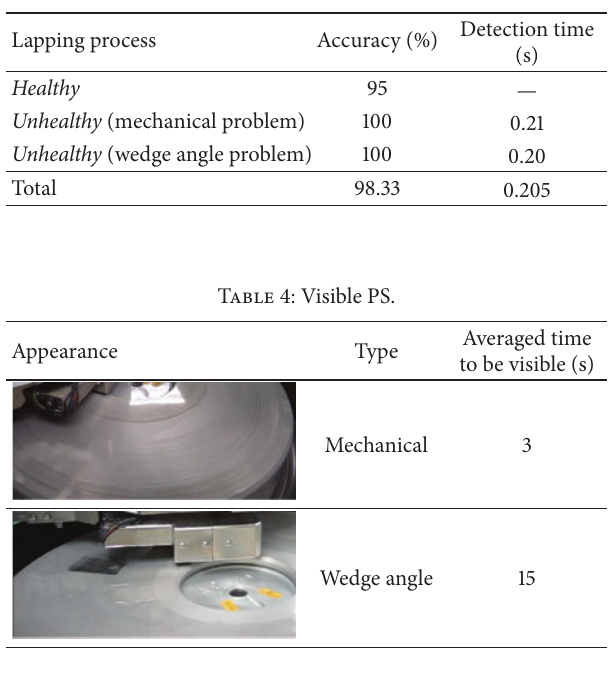
Table 3: Detection results.